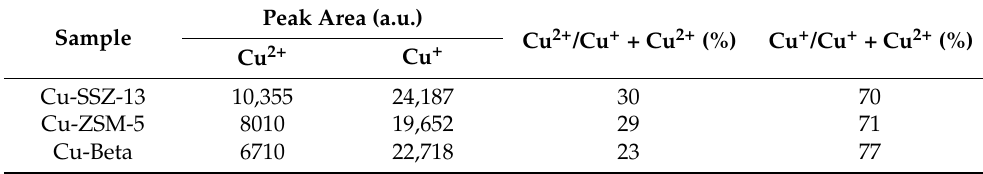
Table 3. The integral areas of Cu 2p determined from XPS spectra over Cu-SSZ-13, Cu-ZSM-5 and Cu-Beta catalysts.